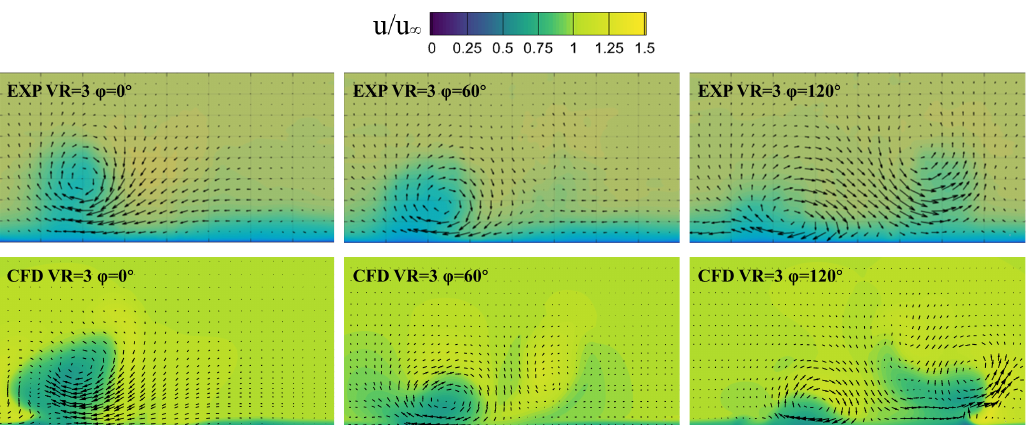
Figure 6. Instantaneous velocity field at x /D = 14.